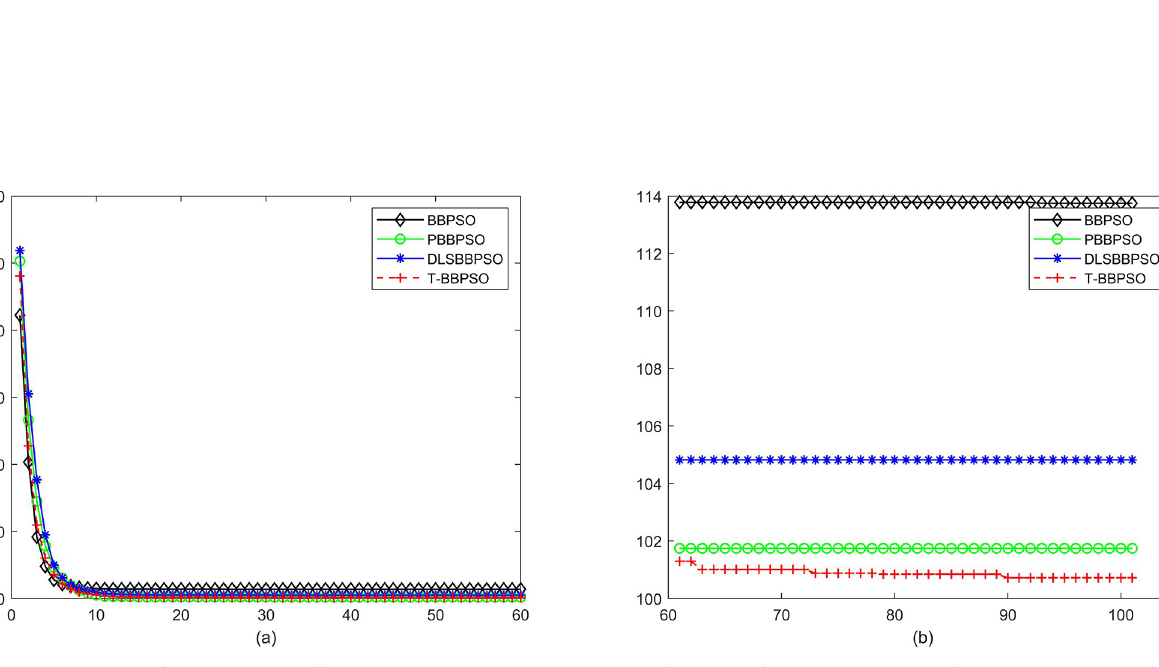
Fig 9. Comparison of convergence speed between BBPSO, PBBPSO, DLS-BBPSO and TBBPSO, f 7 , (a) iteration 0–6000, (b) iteration 6000–10000 the unit is 100 iteration.